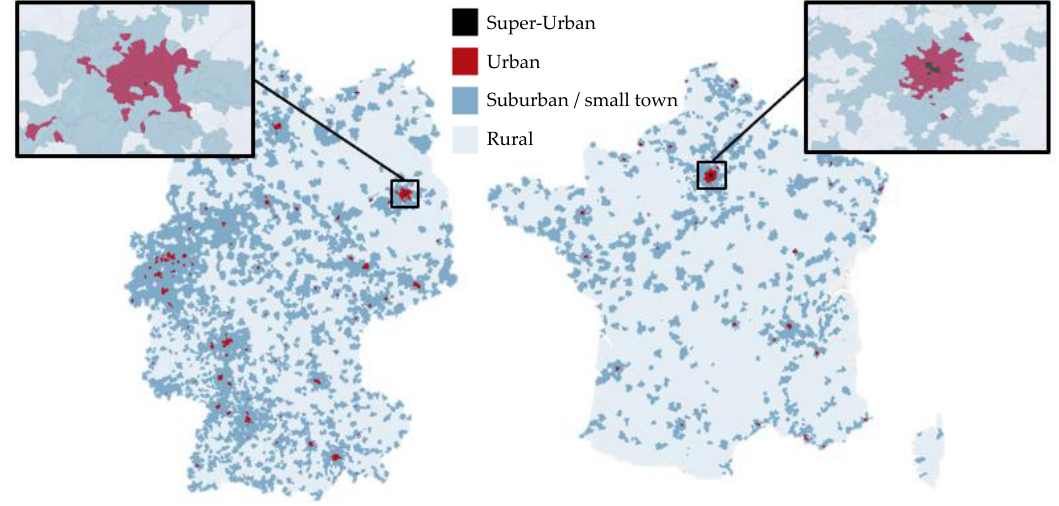
Figure 4. Visual comparison of Germany and France.